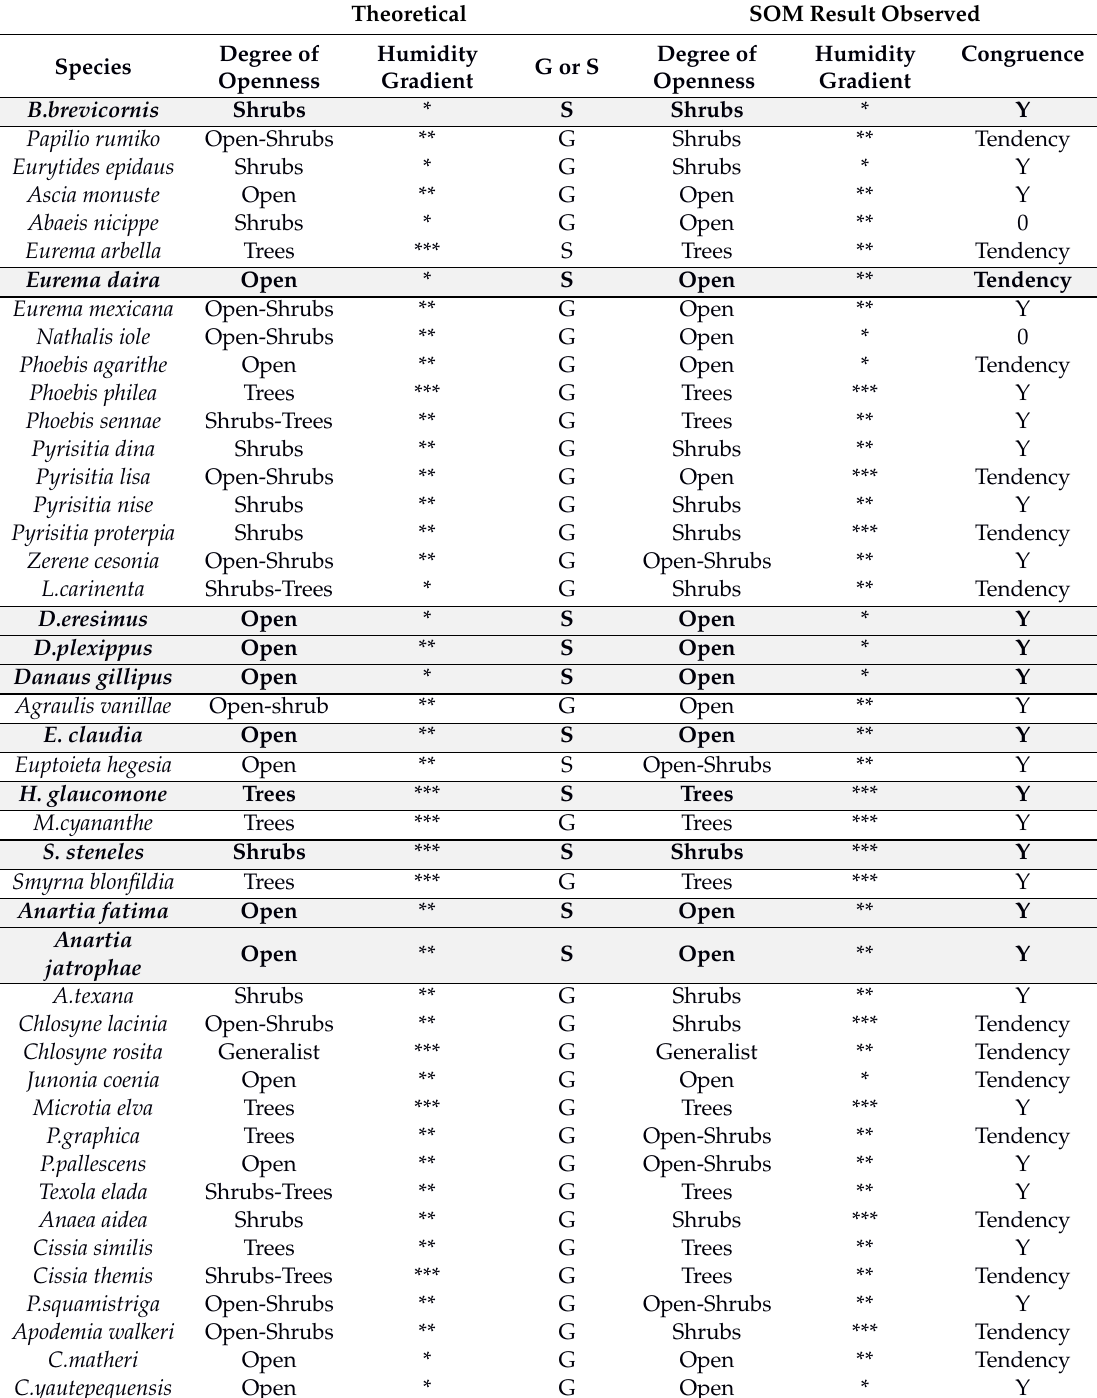
Table A2. Theoretical versus observed distributions (SOM analysis) of the 93 species sampled in the rainy season. “G” is generalist species and “S” is specialist species. Degree of openness: “A” is open, B and C are shrubs and W is trees. Humidity gradient: * is xeric, ** moderately xeric, *** is humid. Evaluation of the congruence: Y (yes): 51 / 93 species (54.8%); N (no): 5 / 93 species (5.4%); 0: compatible but not positive or negative. Tendency: congruence not at 100%. Bold species are considered bioindicators. Note: some generic names were abbreviated to fit the